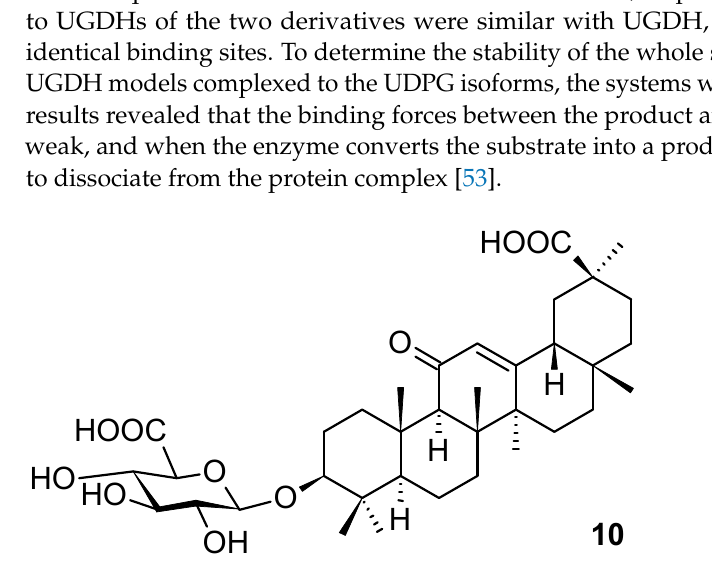
Figure 10. Glycyrrhetinic acid 3 β - D